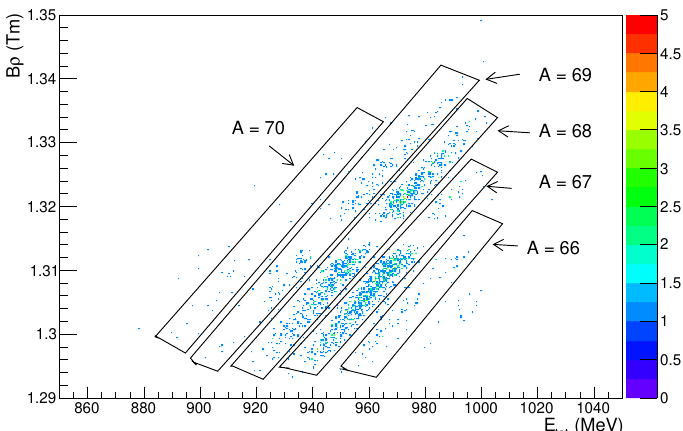
Figure 3. (Color online) Magnetic rigidity vs E tot correlation of ejectiles from the 70 Zn (15 MeV / nucleon) + 64 Ni reaction corresponding to the gate of Z = 29, q = 28. The gap in B ρ is due to a gate set to exclude elastically scattered 70 Zn 29 + ejectiles. Graphical contours are drawn to separate the masses A = 66–70 of Cu 28 +